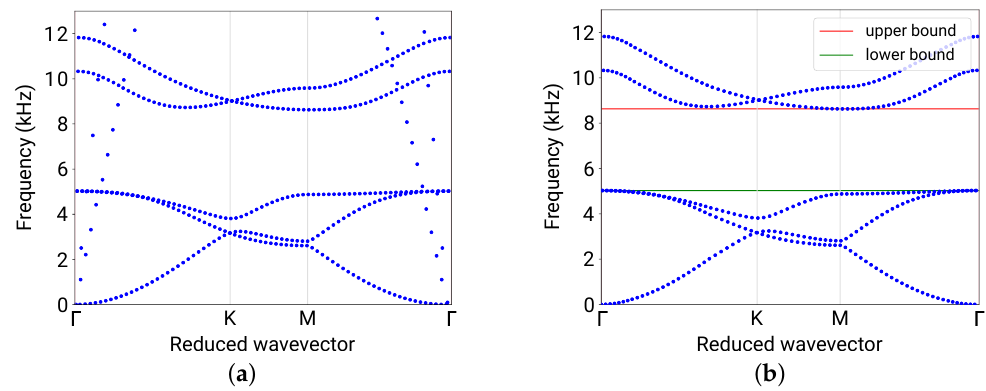
Figure 5. A typical phononic band structure ( f – k -dispersion relation) of the phononic plate with a = 15 mm, w 1 = 6 mm, h 1 = 0.75 mm, w 2 = 1.05 mm, and h 2 = 6 mm. ( a ) The calculated band structure without filtering. The two branches with high slopes are the S 0 / SH 0 modes, and the rest are the A 0 flexural modes. ( b ) The filtered band structure with only flexural modes, with the upper and lower bounds indicated by the red and green bars, respectively.